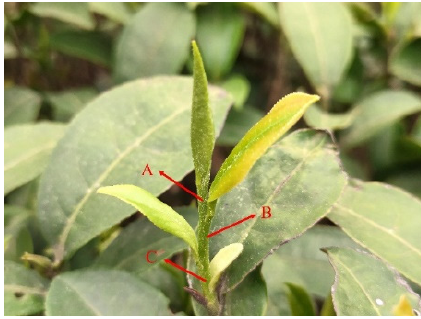
Figure 3. Picking point of tea sprout.